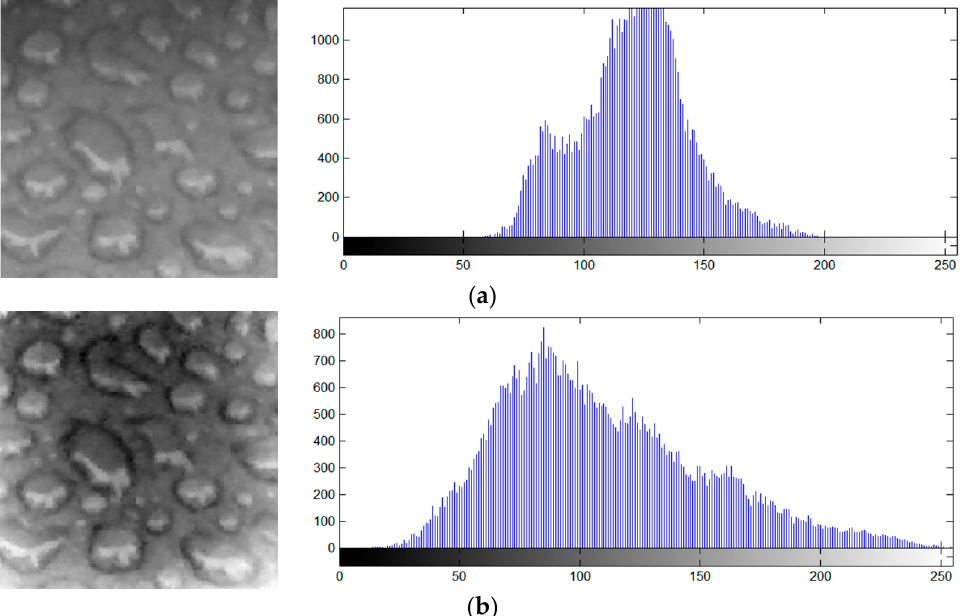
Figure 3. Grayscale histogram of the enhanced image. ( a ) Original image; ( b ) After the Retinex operation.